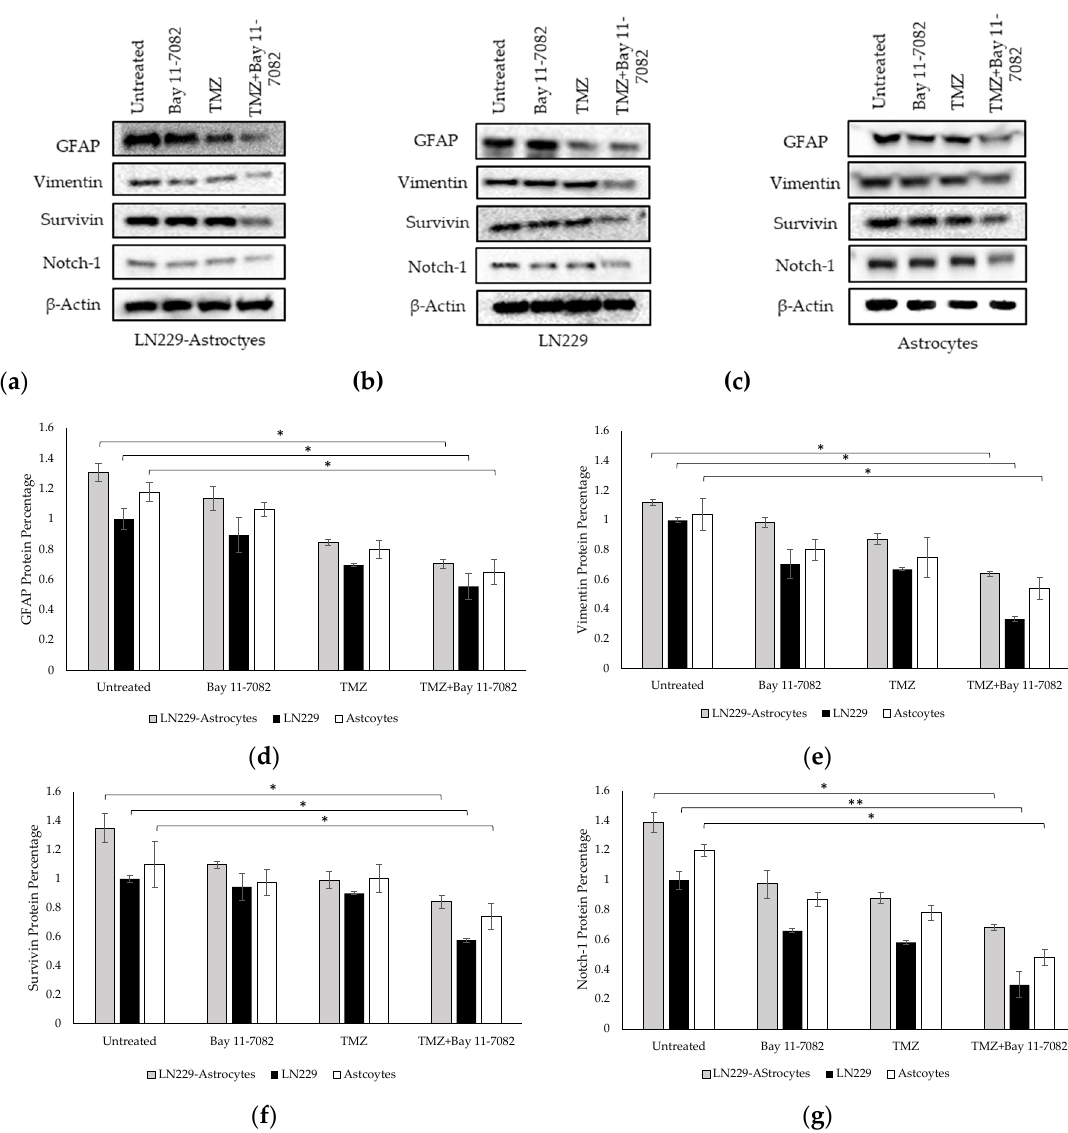
Figure 5. Western blot images of GFAP, vimentin, survivin, and Notch ‐ 1 in ( a ) co ‐ culture and ( b ) LN229 mono ‐ culture and ( c ) astrocytes mono ‐ culture treated with or without drugs for 7 days. ( d ) Quantification of the fold change of GFAP protein. ( e ) Quantification of the fold change of vimentin protein. ( f ) Quantification of the fold change of survivin protein. ( g ) Quantification of the fold change of Notch ‐ 1 protein. The levels of the proteins were quantified using ImageJ. Data were normalized to β‐ Actin. Data represent the mean ± SD of three biological replicates. * indicates p < 0.05, ** indicates p < 0.01.